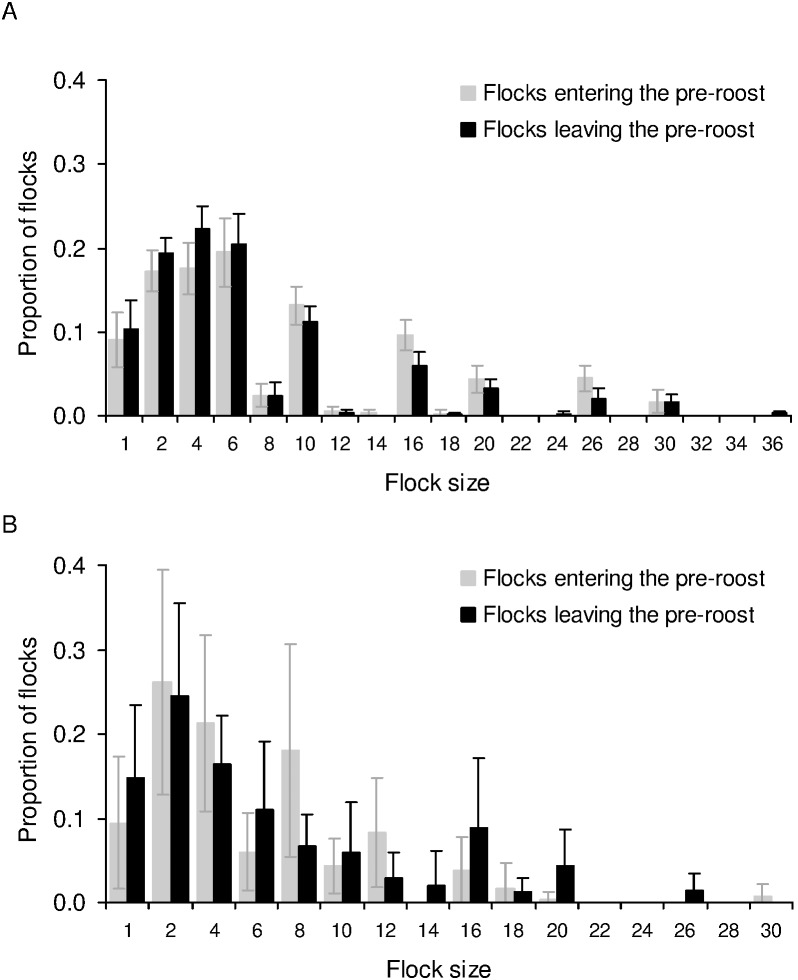
Flock size distributions at pre-roosts.Distributions of sizes of flocks entering and leaving pre-roosts during A) the breeding season, and B) the post-breeding season (error bars are 95% CIs).